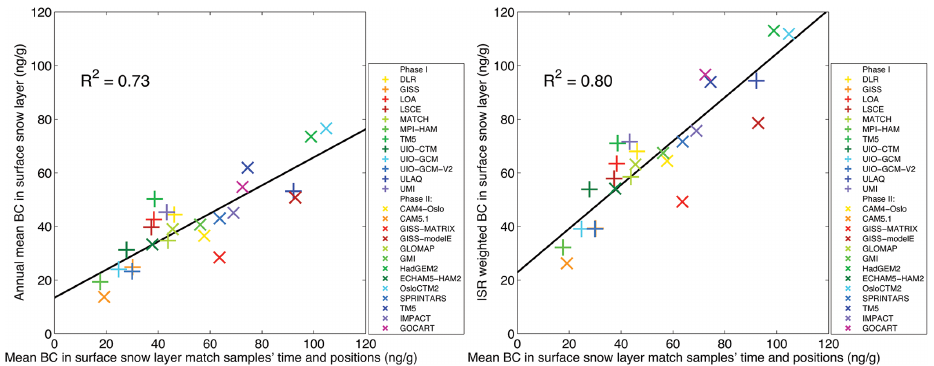
Fig. 4. Relationships between simulated BC-in-snow concentrations averaged over the locations and months of observations and over the whole Arctic region. The abscissa is the surface layer BC-in-snow concentration averaged over grid cells matching the location and time of measurements. The ordinate is the annual mean surface layer BC-in-snow concentration averaged over the whole Arctic region (60 ◦ N to 90 ◦ N) (left panel: Fig. 4a), and averaged over the Arctic with insolation weighting (right panel: Fig. 4b).